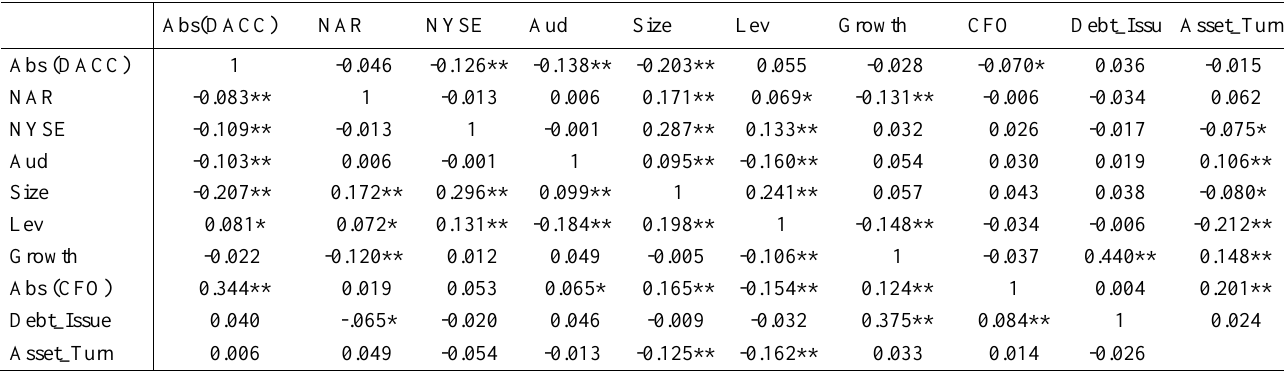
Table 6: Correlation